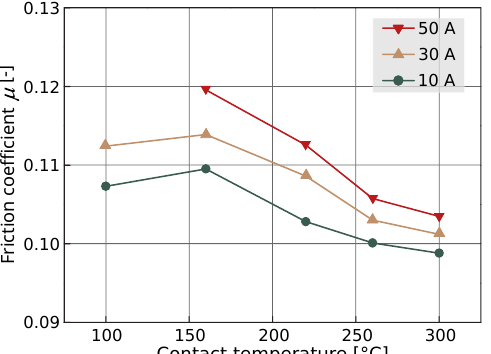
Figure 9. Current and temperature effects on the friction coefficient from an article by Ding T. et al.